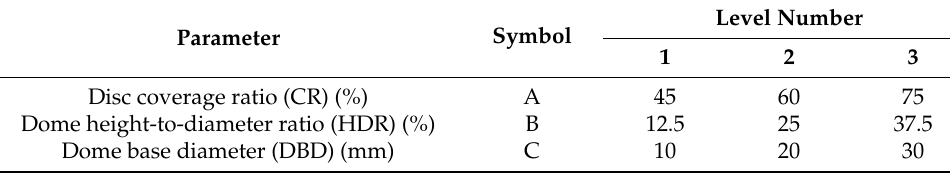
Table 1. The selected values of control parameter levels.